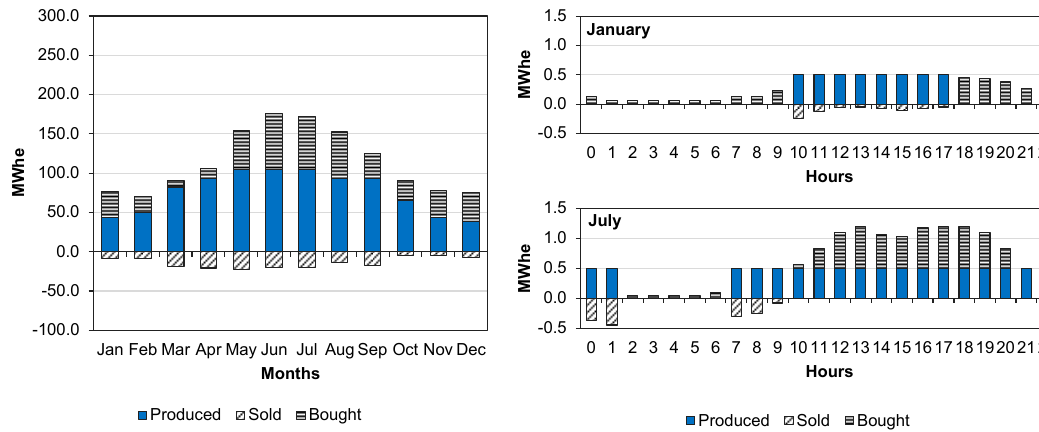
Figure 13. System A. Electricity produced, bought and sold on holidays. Monthly values (left side) and hourly values (right side).